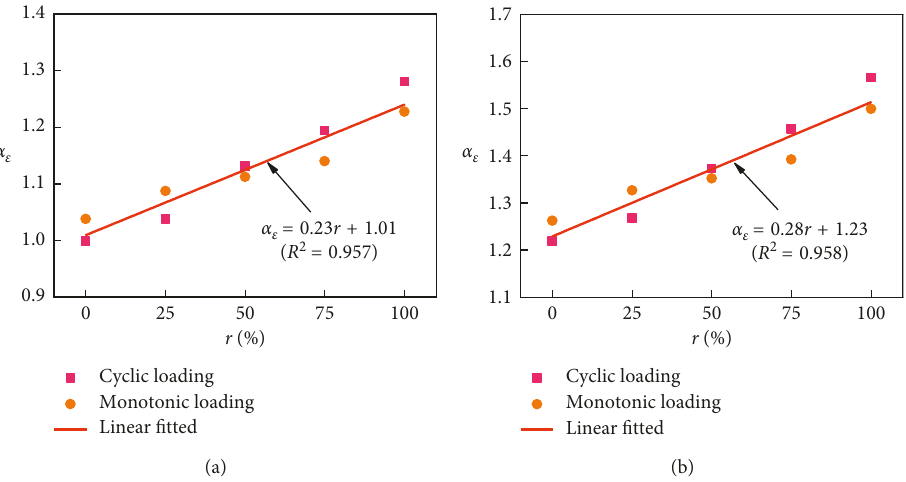
Figure 6: Effect of the RCA replacement percentage on the values of α